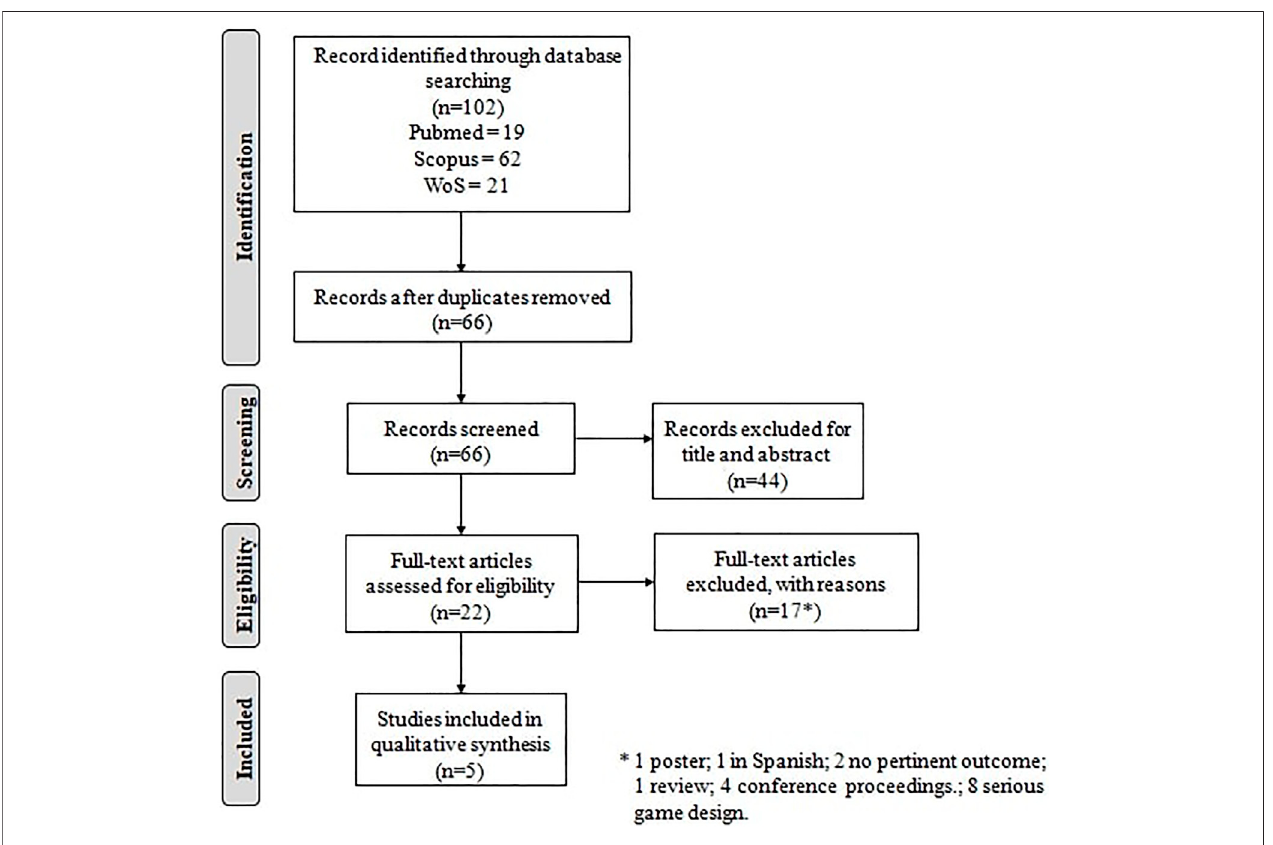
FIGURE 1 | Flow diagram showing the study selection